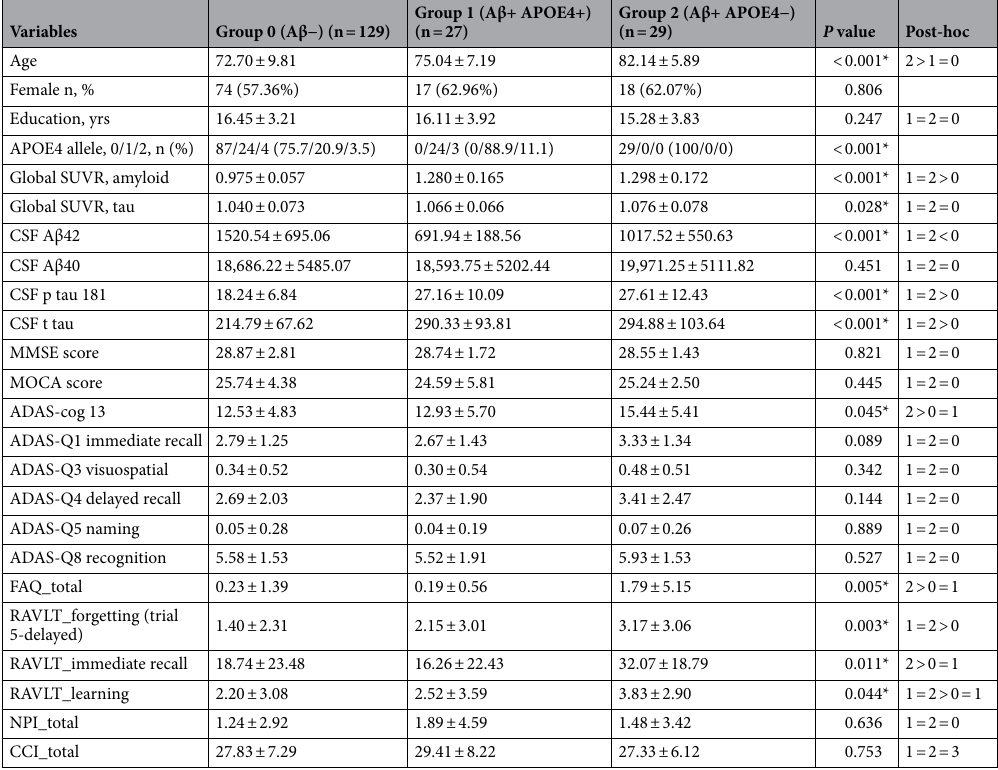
Table 1. Clinical and demographic characteristics according to the biomarker findings. Aβ amyloid β-positive, APOE apolipoprotein epsilon, CSF cerebrospinal fluid, SUVR standardized uptake value ratio, MMSE Mini-